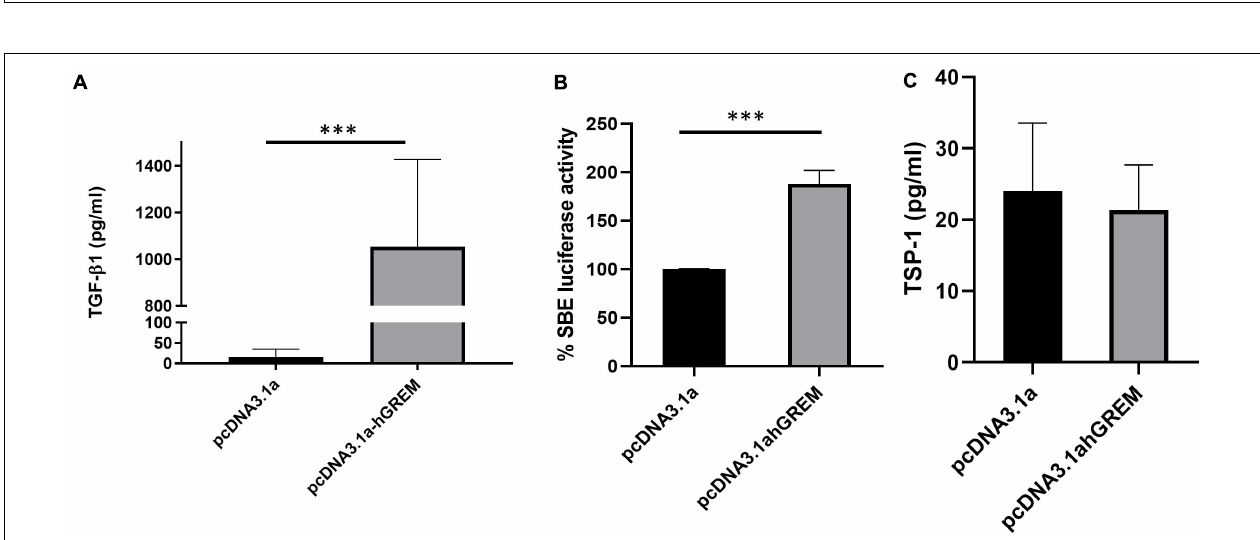
FIGURE 5 | Gremlin-1 increases TGF- β 1 protein. (A) TGF- β 1 was measured by ELISA after overexpression of pcDNA3.1 or pcDNA3.1hGREM, ∗∗∗ P ≤ 0.0001; Student’s t -test; n = 3). (B) Luciferase activity of SBE construct after media was placed onto the cells after transfection with pcDNA3.1 or pcDNA3.1hGREM, P ≤ 0.001; Student’s t -test; n = 3. (C) TSP-1 levels were measured after plasmid transfection in the conditioned media. No significant difference, P ≥ 0.05; Student’s t -test; n = 3.